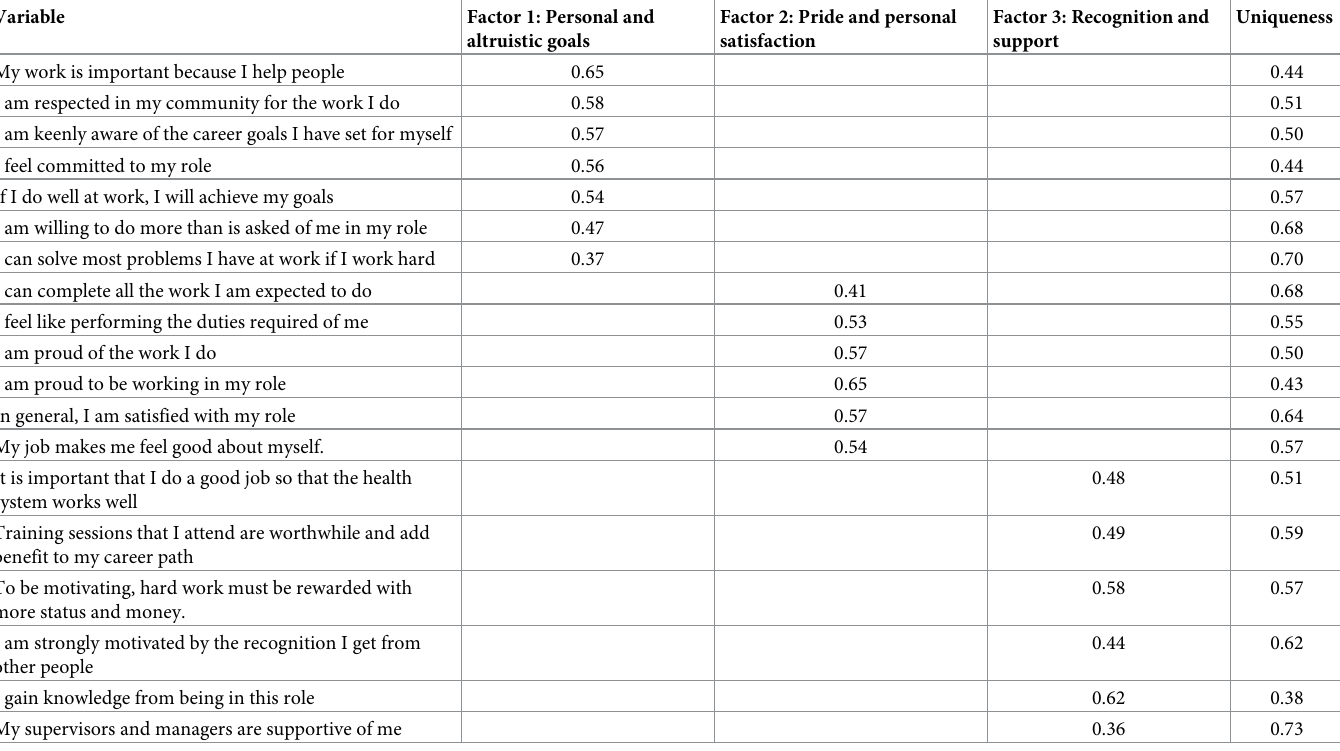
Table 3. Exploratory factor analysis results showing the factor loadings by individual items April 15–May 10,